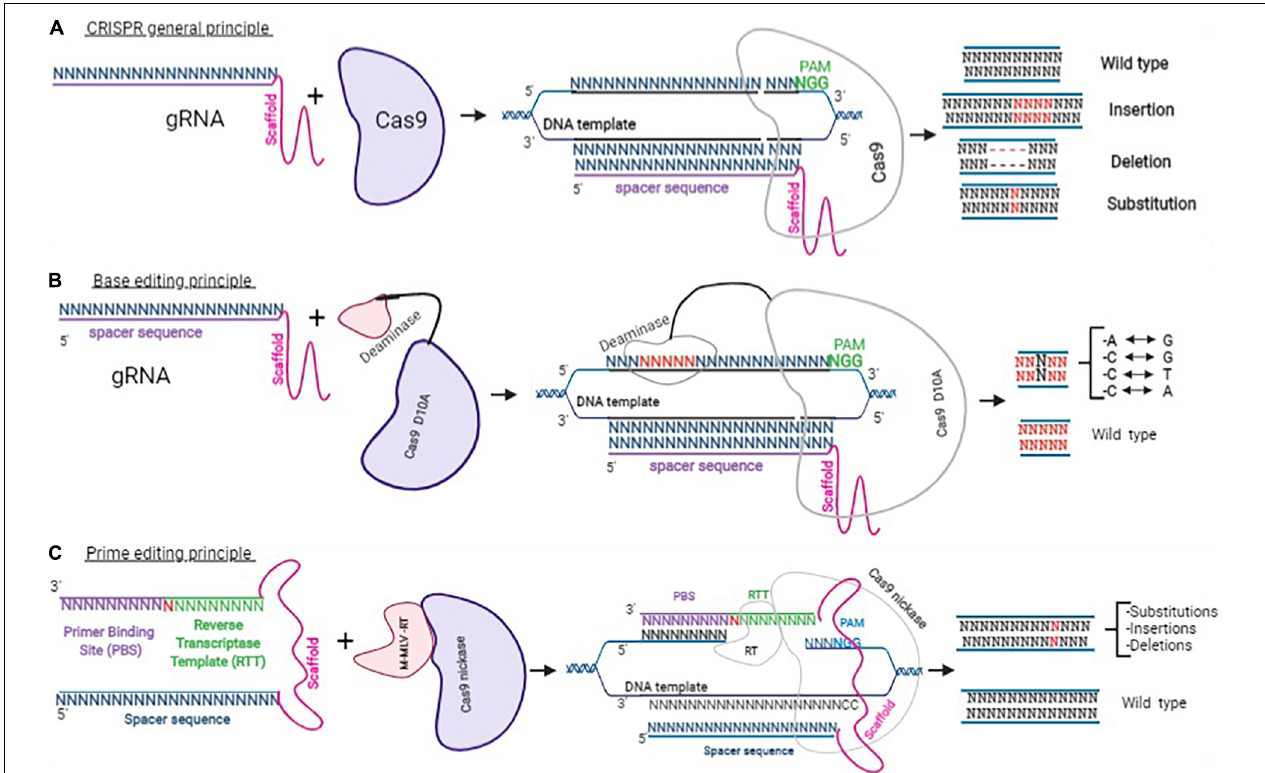
FIGURE 3 | Clustered Regularly Interspaced Short Palindromic Repeats approaches. This figure adapted from Happi Mbakam et al. (58) represents the principle of CRISPR-Cas9 gene modification, which uses a guide RNA and a Cas9 to mediate the nuclease activity resulting in insertions, deletions, or INDELs (A) . Panel (B) represents the general mechanism for base editing, which uses a sgRNA (spacer sequence + scaffold) and a Cas9 nickase fused with a cytosine or an adenine deaminase. Depending on the deaminase used, after binding with a specific DNA template, a cytosine is chemically modified into a thymine or an adenosine into a guanine. Panel (C) shows a PE2 protein (a Cas9 nickase fused with an engineered reverse transcriptase enzyme from M-MLV) and a pegRNA. The pegRNA is an extended sgRNA including the spacer sequence and the constant sequence (scaffold), a reverse transcriptase template (RTT), and a primer binding site (PBS). The binding of PE2 and pegRNA with a DNA target permits to induce insertion, deletion, or substitution of a few